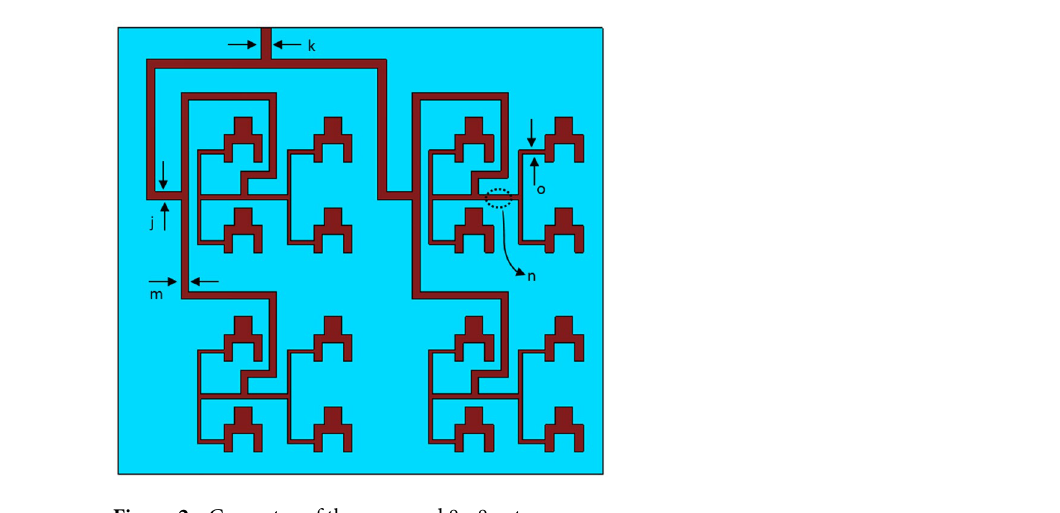
Figure 2. Geometry of the proposed 8 × 8 antenna array.